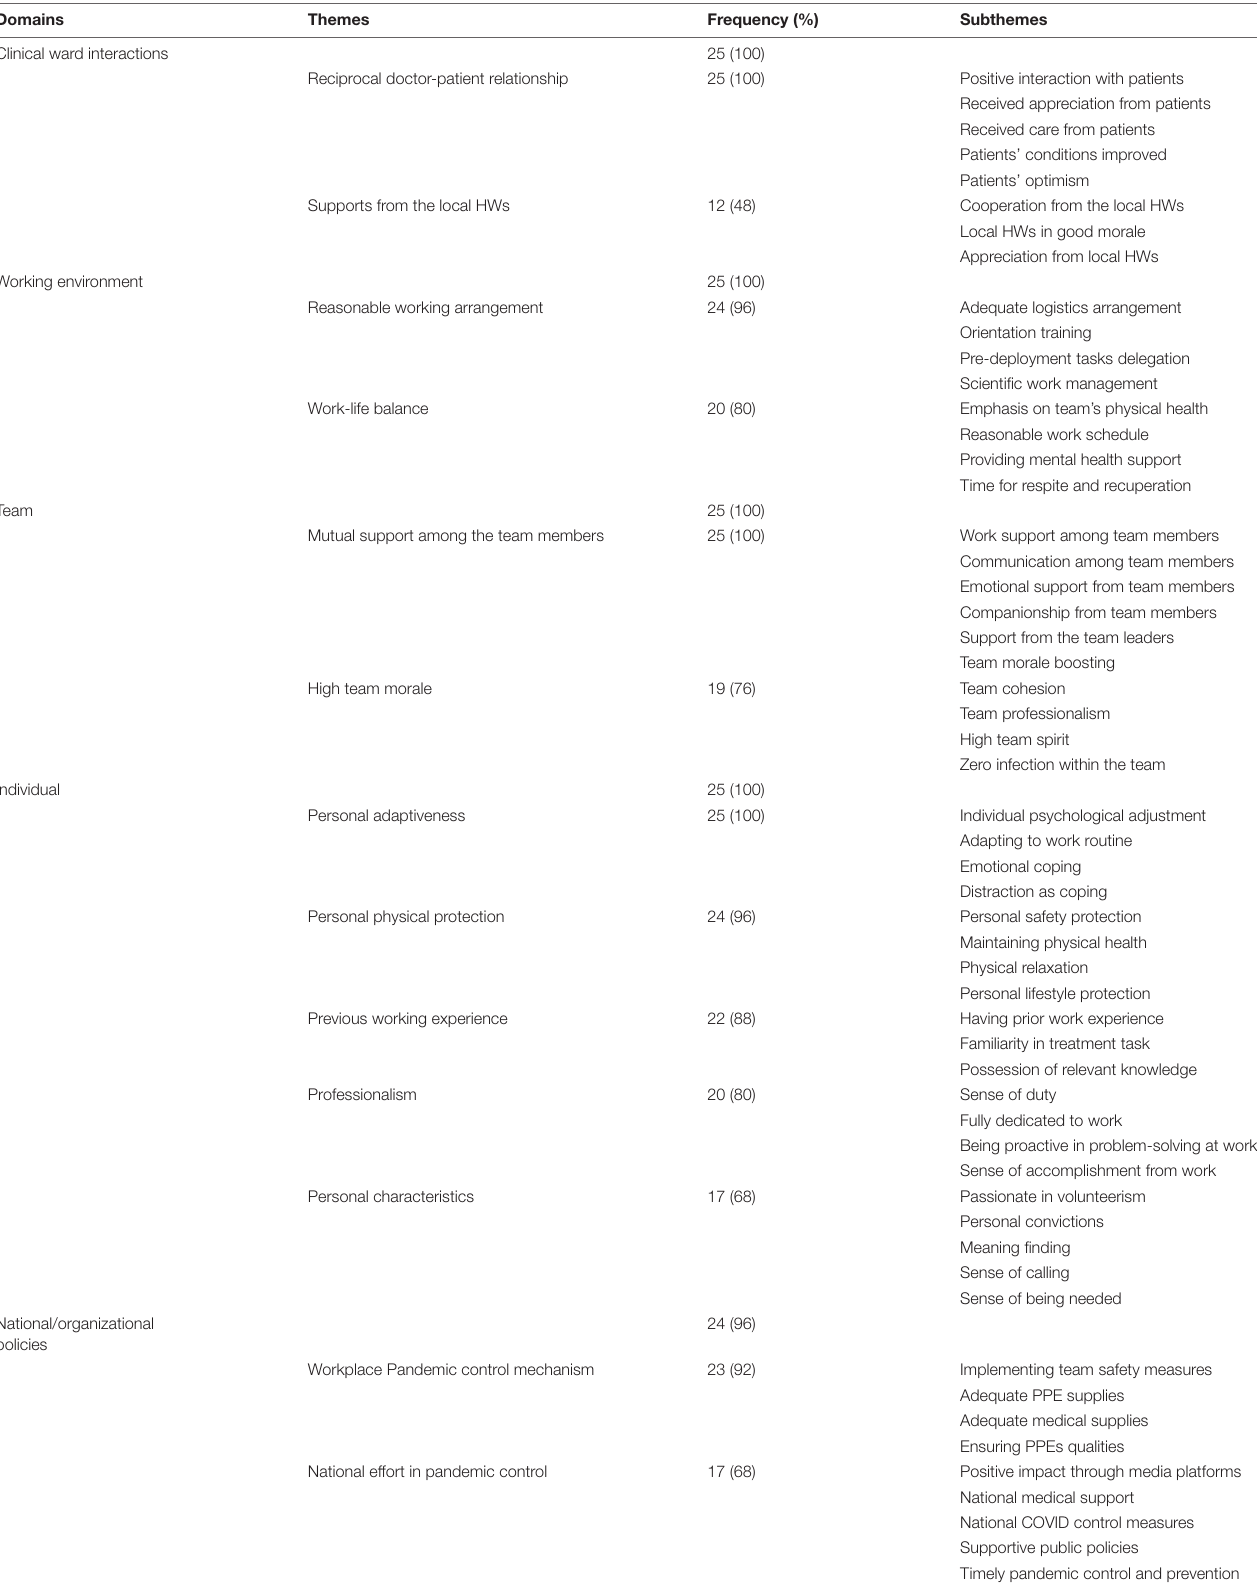
TABLE 4 | List of domains, themes, and subthemes of protective factors for the well-being of the 25 interviewees.